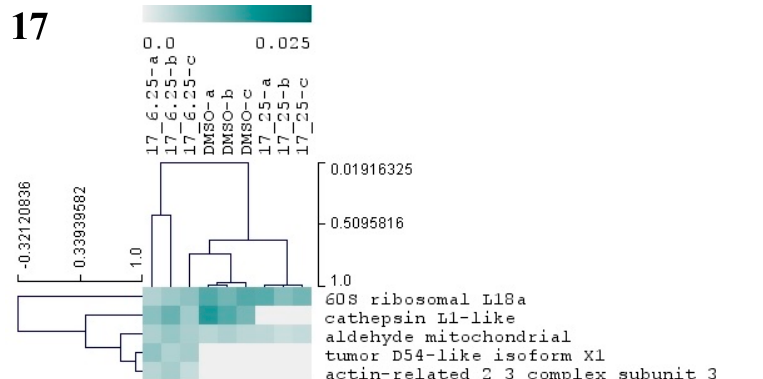
Figure 7. Hierarchical cluster analysis of the differential proteins from M. galloprovincialis larvae exposed to three different antifouling compounds, 7 , 10 , and 17 . On the vertical axis of the dendrogram: clustering of proteins with similar abundance profiles. On the horizontal axis: grouping of samples with similar proteome. Only proteins with significant changes ( p < 0.05) in abundance (based on NSAF values) are presented in the dendogram. The relative abundance values (NSAF) are represented in color gradient from 0.0 to 0.025. Further information on NSAF values, significant p-values, and names of all differentially abundant proteins is included in Supplementary Table S2.